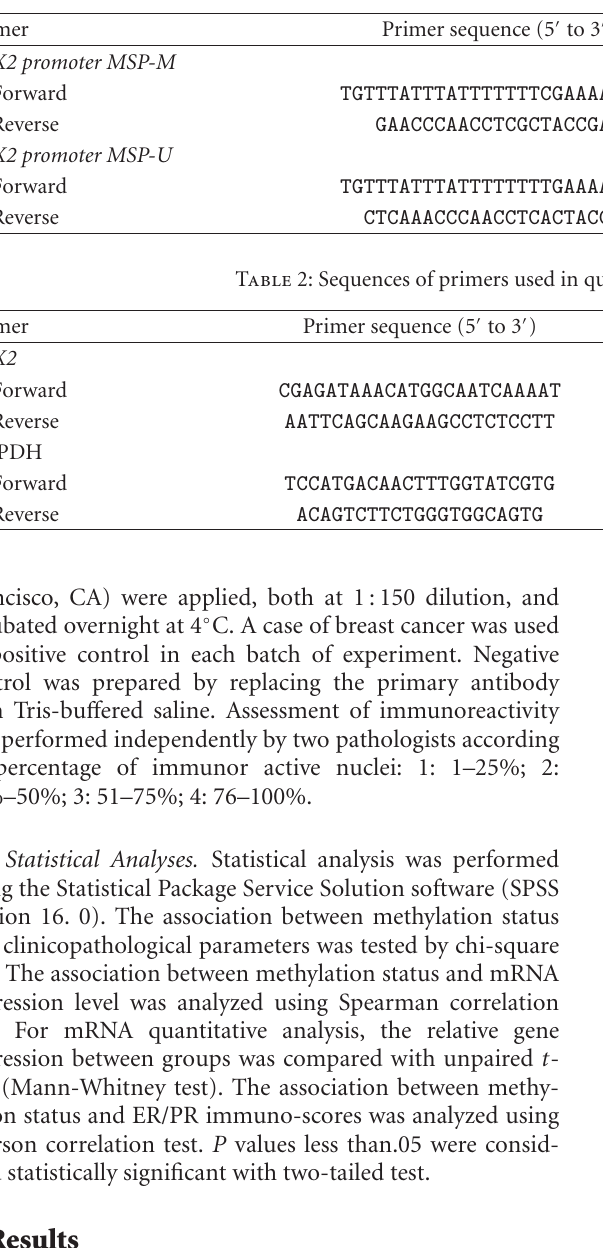
Table 1: Sequences of primers used in SOX2 methylation-specific PCR.